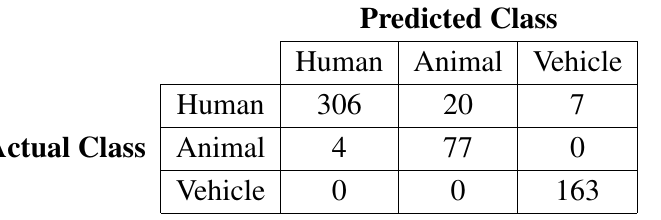
Table 2. Confusion matrix of classification